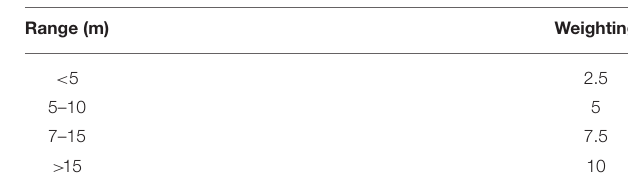
TABLE 2 | Aquifer potential as a function of overburden thickness [modified with the permission of “RMZ—Materials and Geoenvironment” after (Sunmonu et al., 2012)].